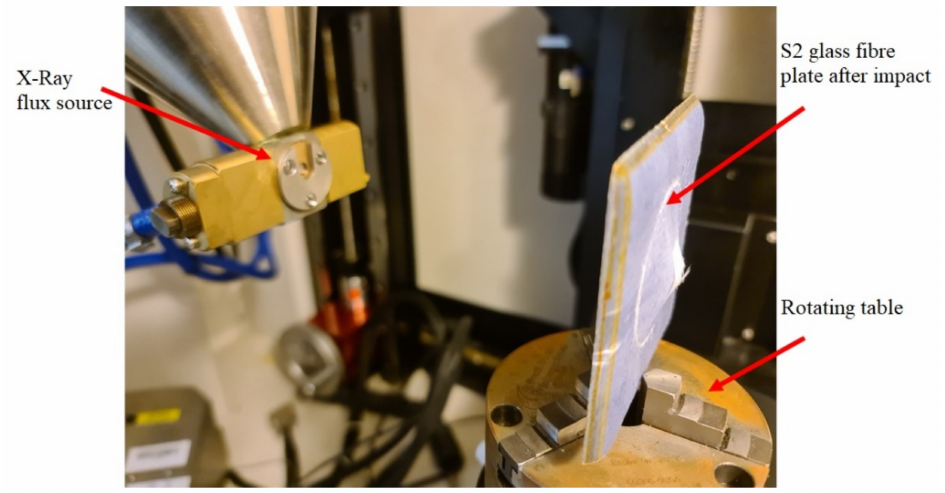
Figure 3. CT scan of glass fibre plates after